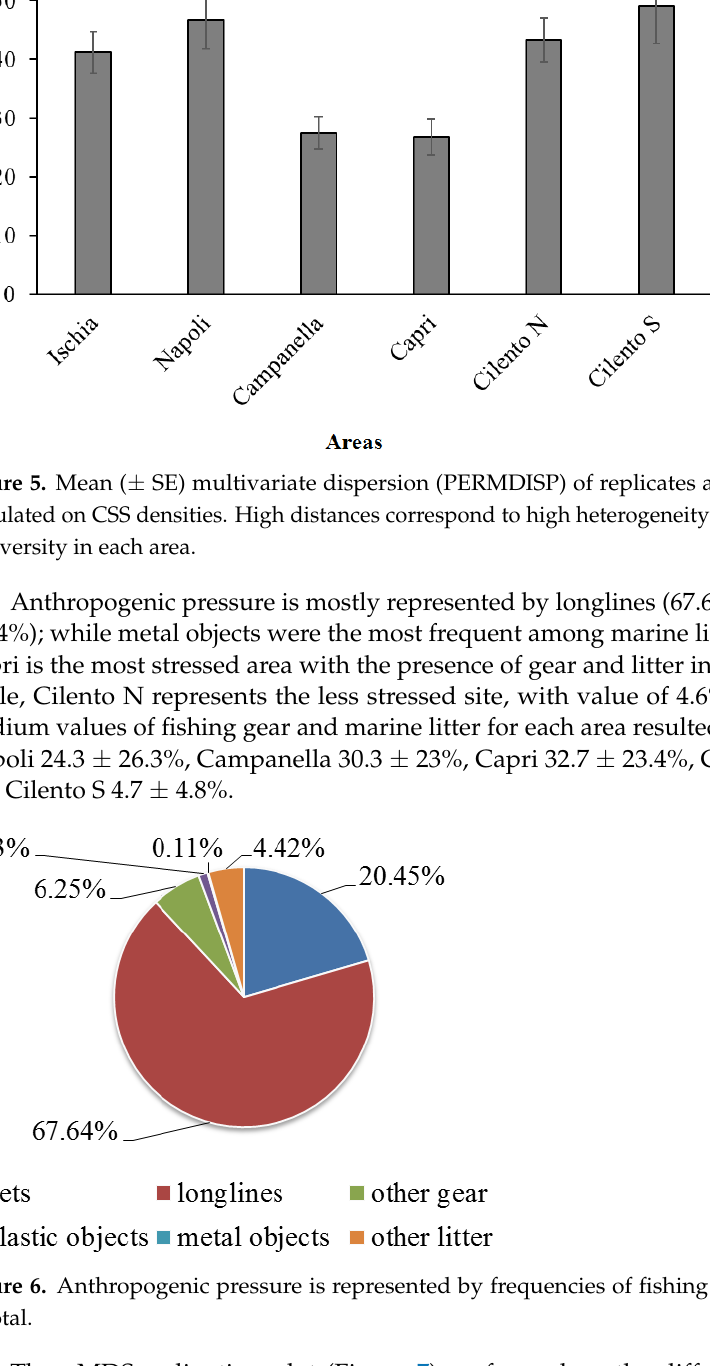
Figure 4. The CAP analysis on CSS densities; straight lines are vectors of species whose orientation and length are proportional to the most correlated areas. Only species with a correlation Pearson index > 0.4 are shown. The circle represents a 95% confidence interval.